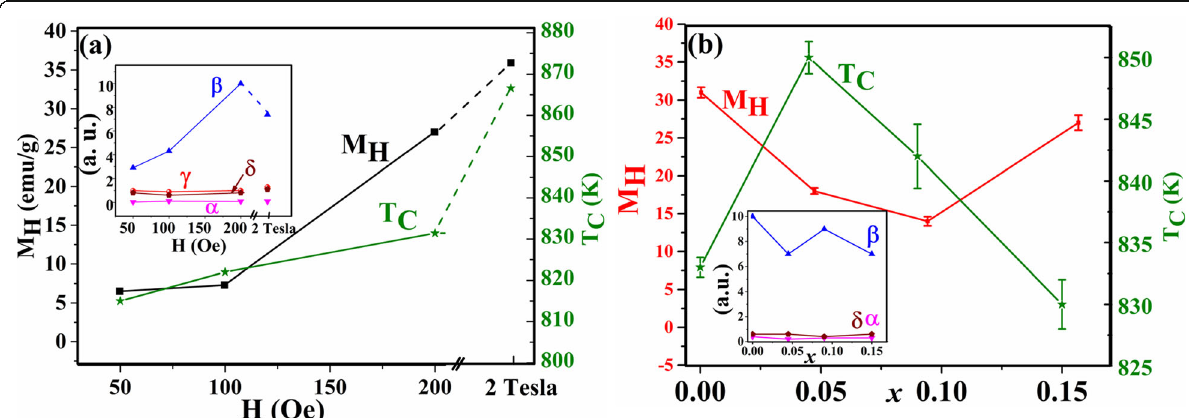
Fig. 15 a Change for the pristine Fe 3 O 4 of M H (left) and T C (right) with the applied external magnetic field H and (the insets show the change in different parameters α (purple), β (blue), and δ (brown) in both cases and with γ (red) with respect to external magnetic field) b for Sn x Fe 3-2/3 x O 4 samples as a function of x taken at H = 200 Oe (the insets show the change in different parameters α (purple), β (blue), and δ (brown) in both cases and with γ (red) with respect to x